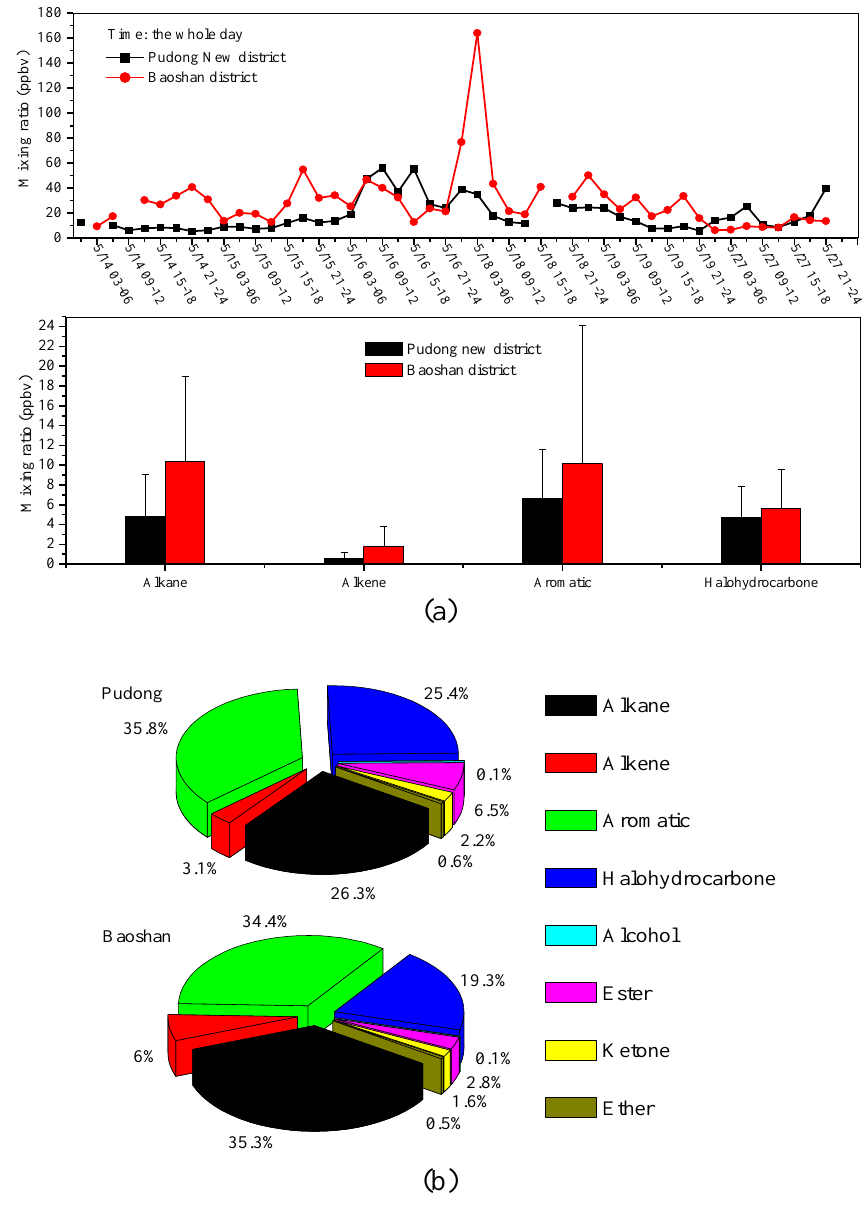
Figure 6. (a) Comparison of the total VOC concentrations during the whole day (8 samples per day) at 2 sampling sites (Pudong and Baoshan) during May, 2009 (b) The measured VOC during the whole day for different VOC groups (alkane, alkene, aromatic, halohydrocarbone, alcohol, ester, ketone, and ether) at 2 sampling sites (Pudong and Baoshan) during May,